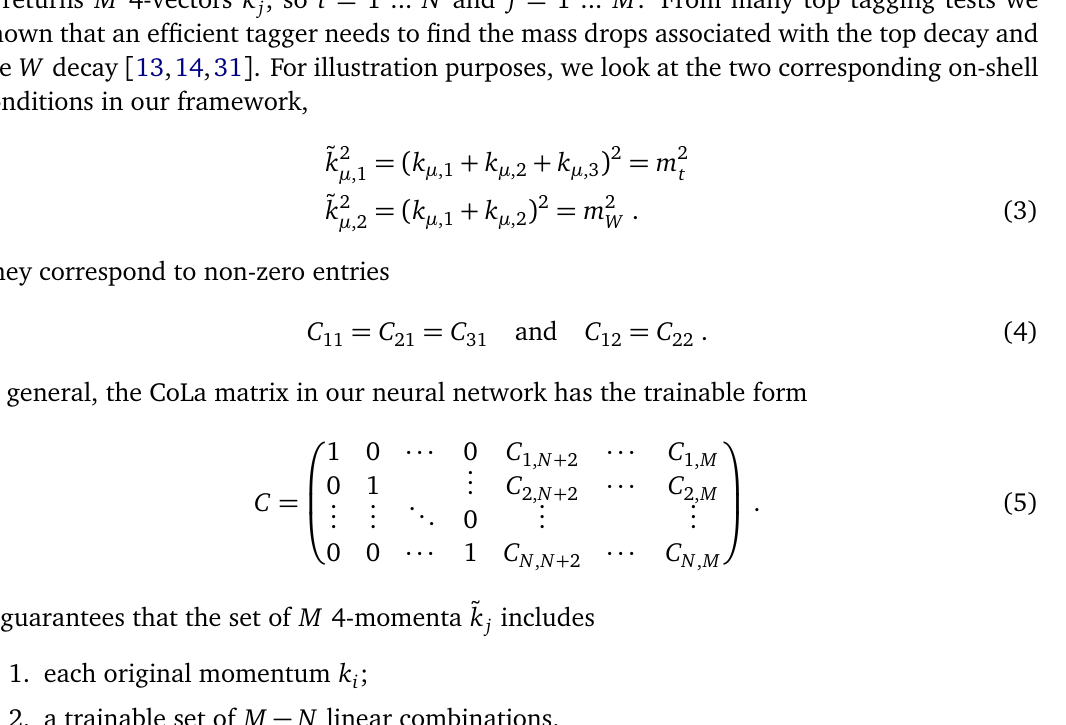
Figure 1: Jet image illustrating a signal event, showing 20 4-vectors k µ > 1 GeV on the calorimeter energy threshold k 0